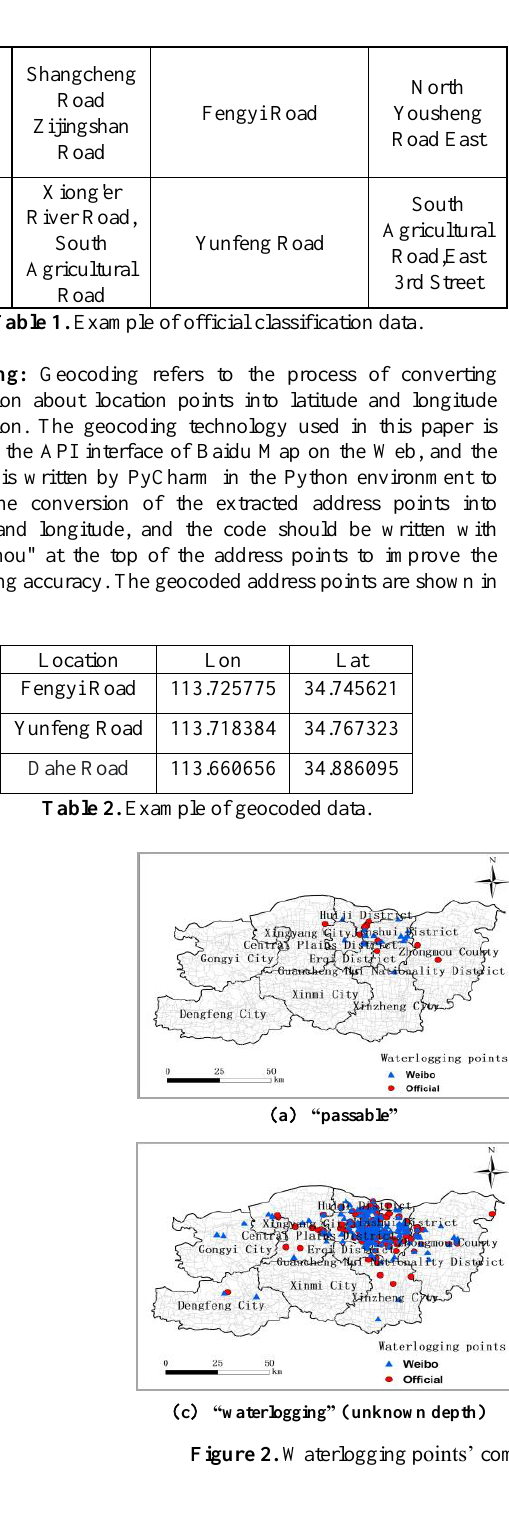
Figure 2 ： To verify the reliability of Weibo data in